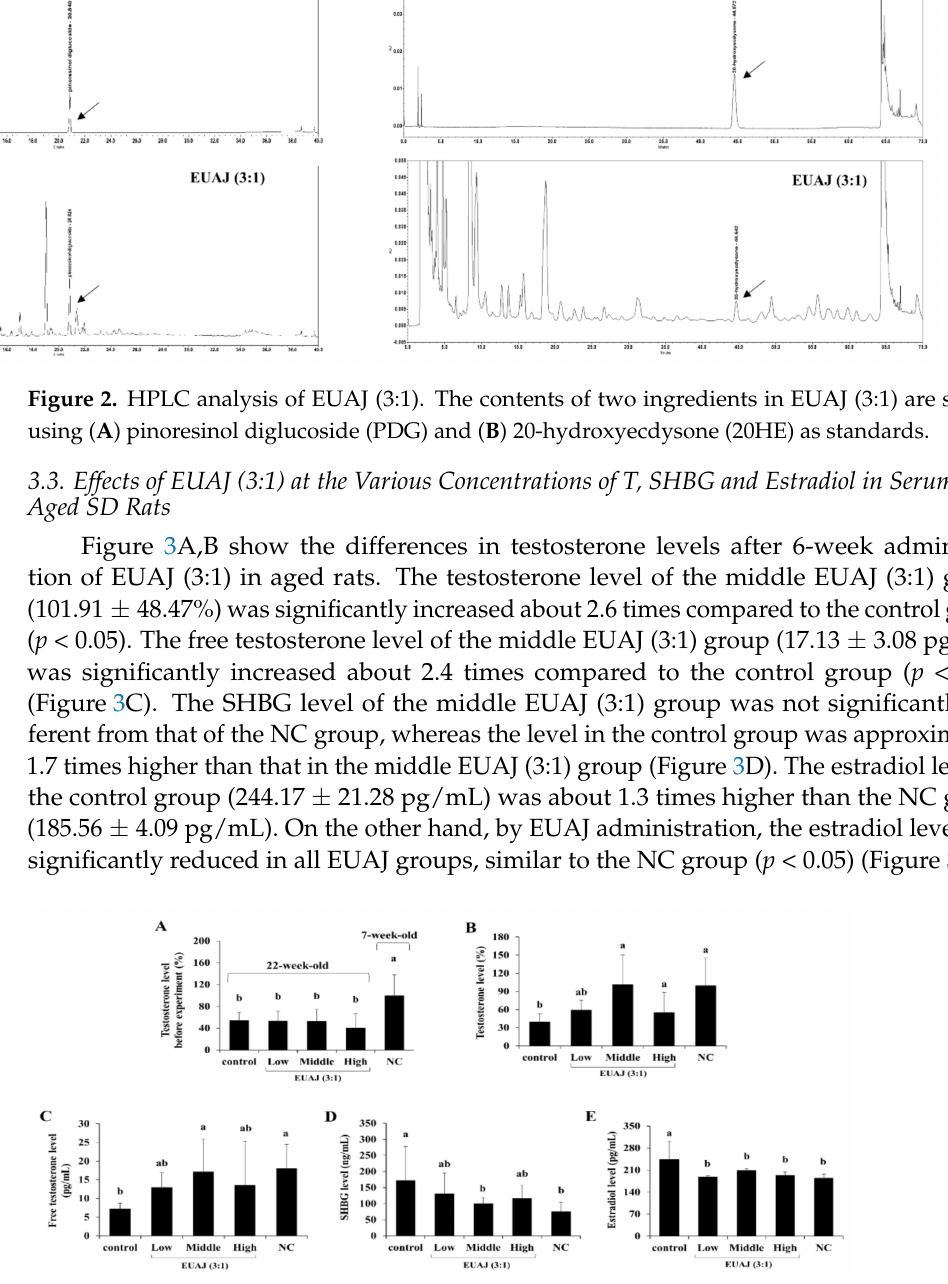
Figure 3. The effects of various concentration of EUAJ on total testosterone, free testosterone, SHBG and estradiol in serum of SD rats. Serum testosterone levels of SD rats were shown in ( A ) before administered by EUAJ (3:1). The level of ( B ) total testosterone, ( C ) free testosterone, ( D ) SHBG and ( E ) estradiol in serum of SD rats via oral gavage of various concentration of EUAJ (3:1) for 6 weeks. Values are presented as means ± SD. Different superscript letters show a significantly difference at p < 0.05, as determined by Duncan’s multiple range test. Control; saline, low; EUAJ (3:1) 20 mg/kg, middle; EUAJ (3:1) 40 mg/kg, high; EUAJ (3:1) 80 mg/kg, NC;